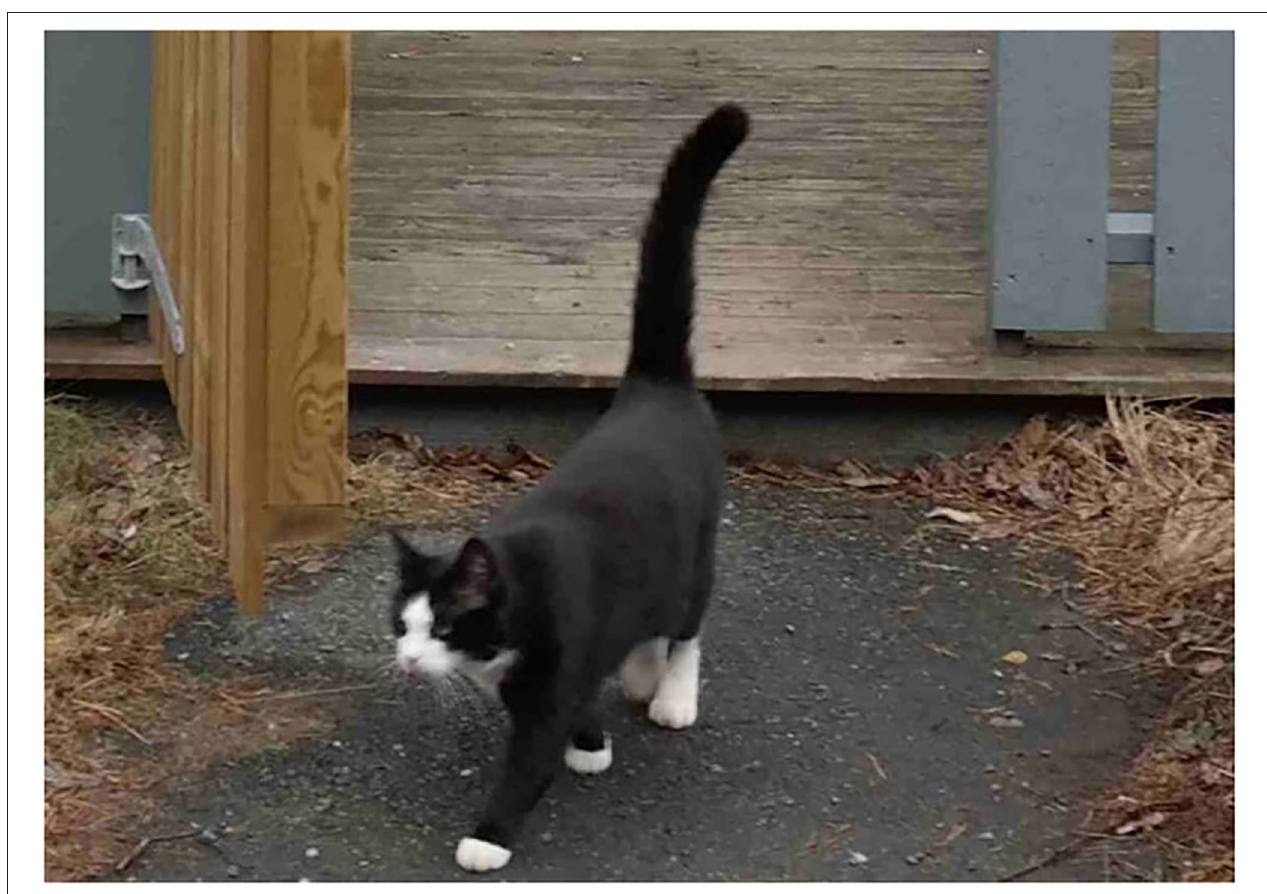
FIGURE 3 | The wandering cat